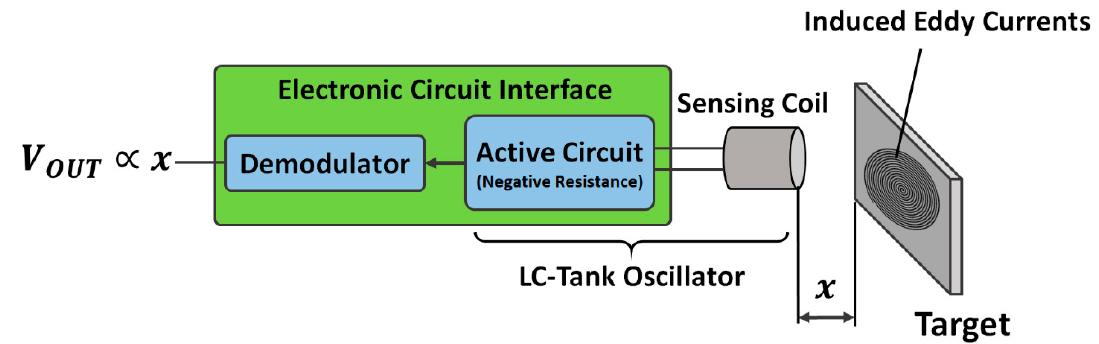
Figure 1. Eddy current sensing system. Simplified block diagram of the proposed solution.